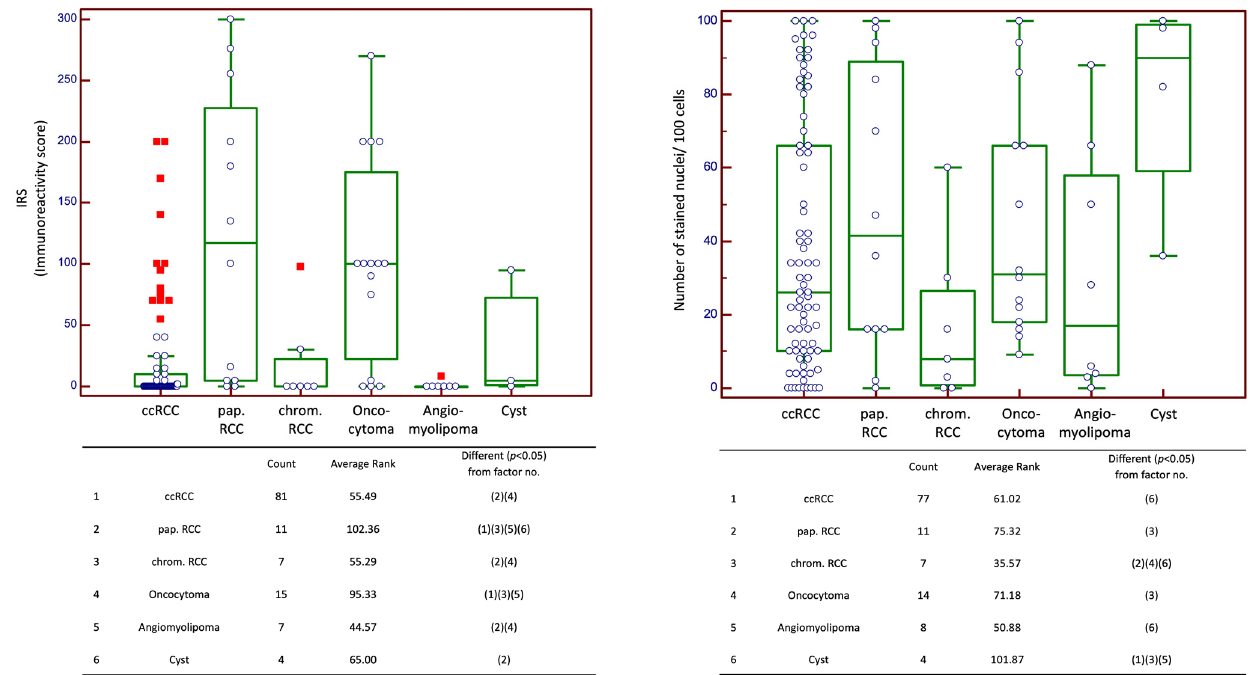
Figure 2. Cytoplasmic and nuclear expression scores for cohort n 2 (cohort of various histological entities) with Kruskal–Wallis and post hoc analysis. Abbreviations: IRS: immunoreactivity score; ccRCC: clear cell renal cell carcinoma; pap. RCC: papillary renal cell carcinoma; chrom. RCC: chro- mophobic renal cell carcinoma. Green box represents median and 1st and 3rd quartile. Purple circles are individual values, circles outside the box are outside values. Red squares are far out values.